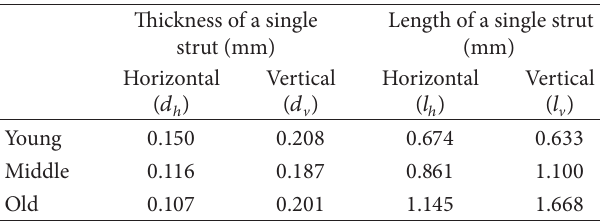
Table 1: Geometries for trabecular lattice models for the young, middle, and old